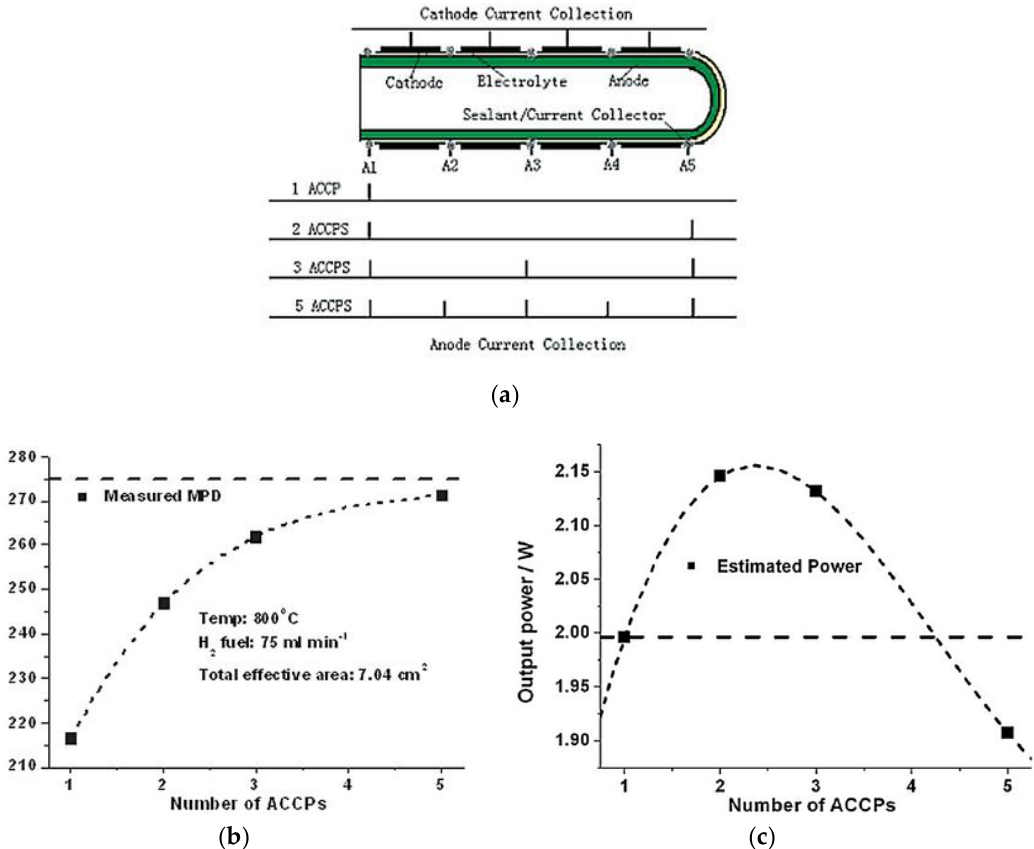
Figure 16. Segmented tubular cell ( a ) anode current collector configurations; number of anode current collectors versus ( b ) maximum power density and ( c ) total power available from the cell